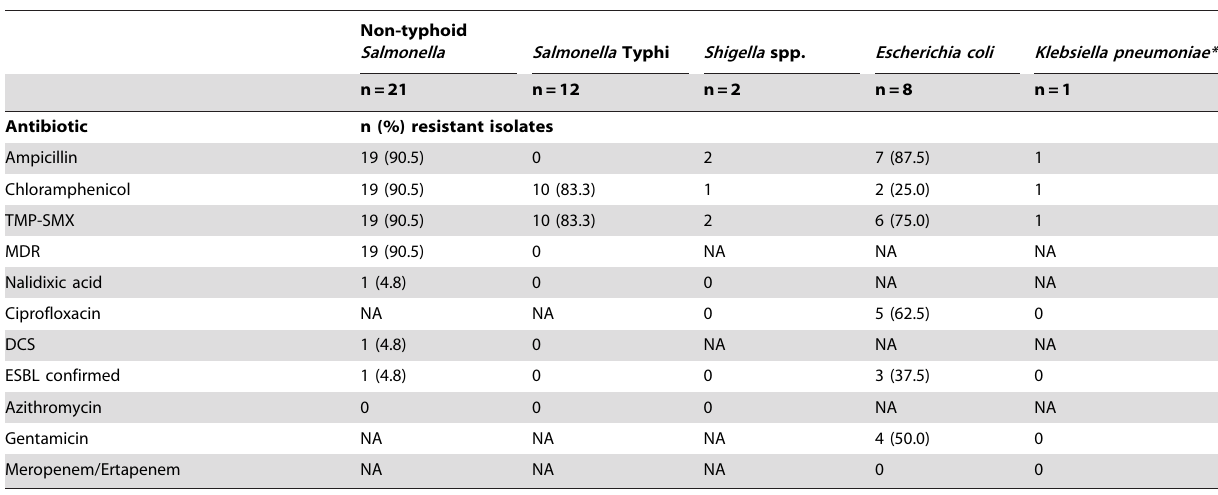
Table 4. Antibiotic resistance patterns of Enterobacteriaceae